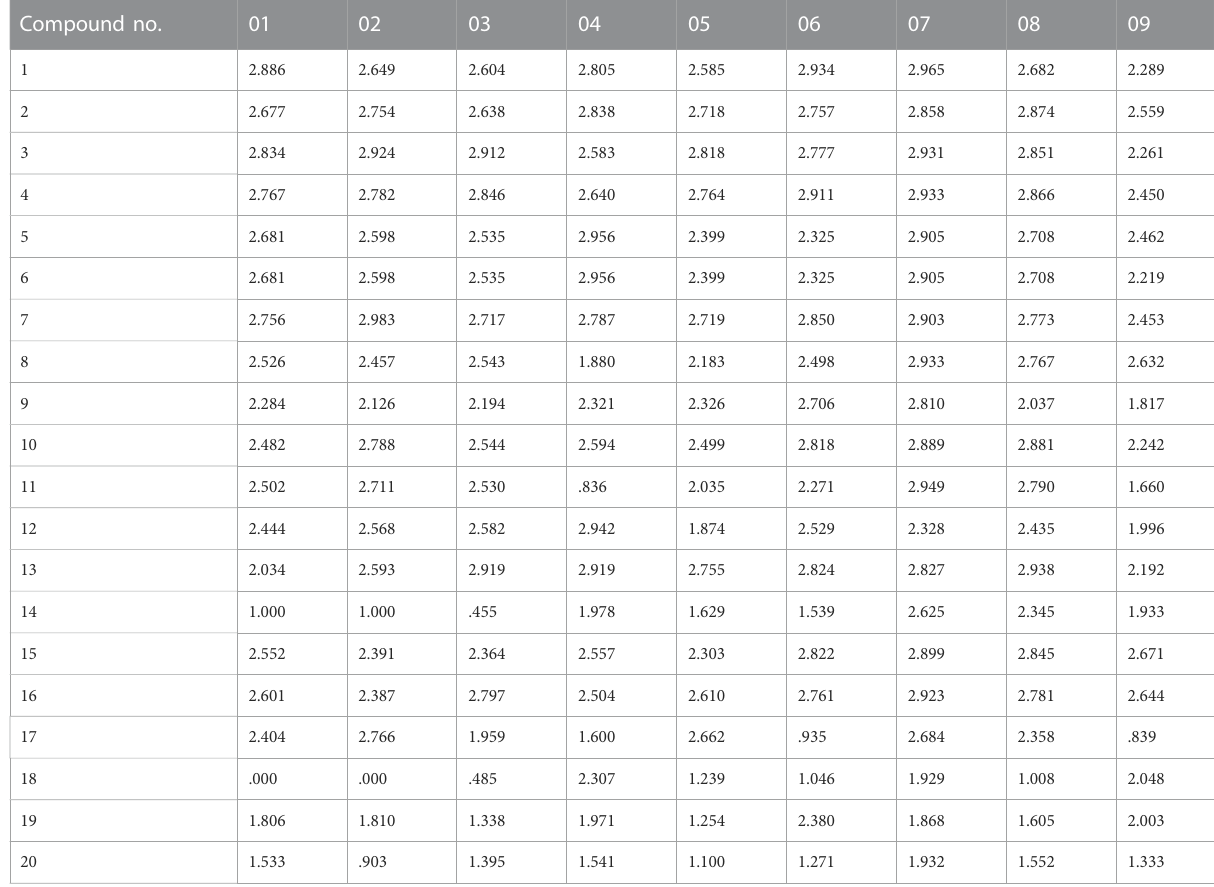
TABLE 4 Matching results of nine pharmacophore models for compounds of the training set. Compound no.